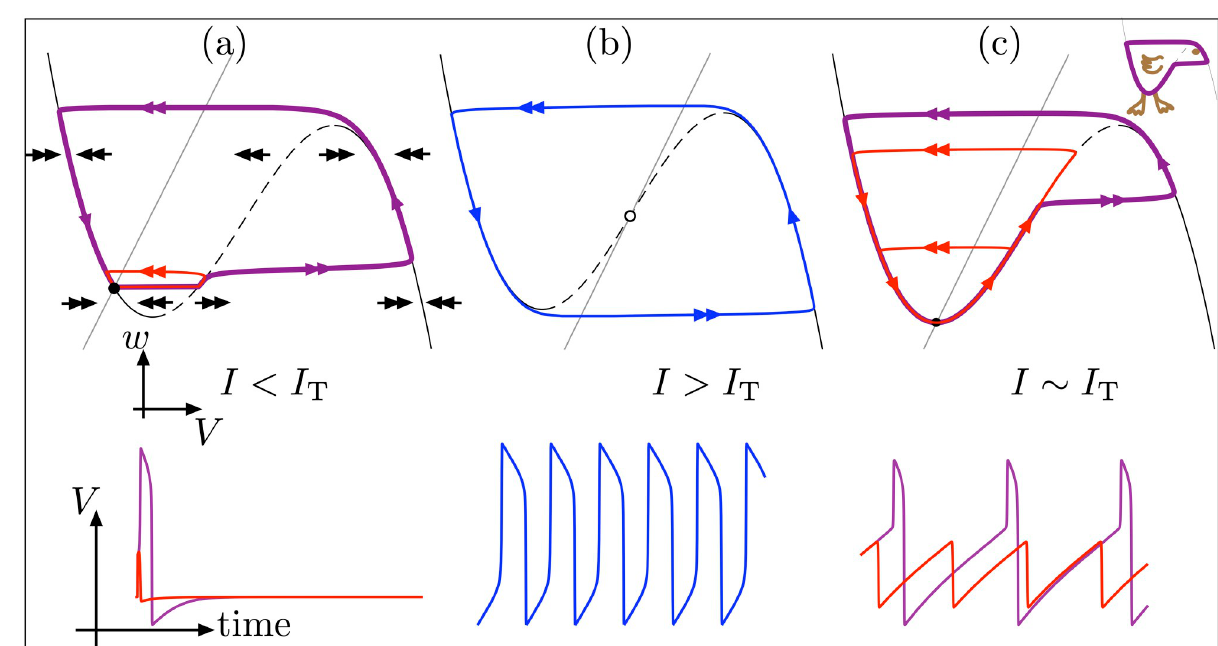
Fig 1. Ducks at the transition from rest to spikes in the FitzHugh–Nagumo model. The dynamics are represented in the phase plane (upper panels) and as illustrative time courses (lower panels). When increasing the applied current I , the system’s dynamics transitions from a stable equilibrium (rest state, black dot in (a)), which is excitable, to a strongly attracting limit cycle (repetitive spiking state, in blue in (b)). The excitable structure in panel (a) is further illustrated with 2 trajectories whose initial conditions are at the stable equilibrium (rest state) and with a step current of slightly different amplitude: One trajectory (in red) stays below threshold, while the other one (in purple) crosses threshold, fires an action potential, and then returns back to the rest state. The transition from (a) to (b) is continuous but confined to a very small range of I values around I T . At I * I T , special solutions called ducks emerge (c), which stay close to the unstable part of the V -nullcline, shown as a cubic curve whose attracting branches (resp. repulsive branch) are displayed as solid (resp. dashed) black lines. Two ducks shown in red stay below threshold and correspond to subthreshold oscillations, while one (in purple) crosses threshold and corresponds to a near-threshold spiking solution. Also shown in the top row is the w linear nullcline and the equilibrium point (filled circled when stable, open circle when unstable) at the intersection between the 2 nullclines. Single (double) arrows represent fast (slow) flow. Notice that the purple trajectory in panel (c) has the shape of a leftward-directed duck’s profile; see top-right inset. The bottom row shows the time courses of the membrane potential V for all trajectories displayed on the top row, keeping the same colors; for panel (c), only the time series of the largest red cycle and of the purple one are shown. Equations and parameter values are given in S1 Text.